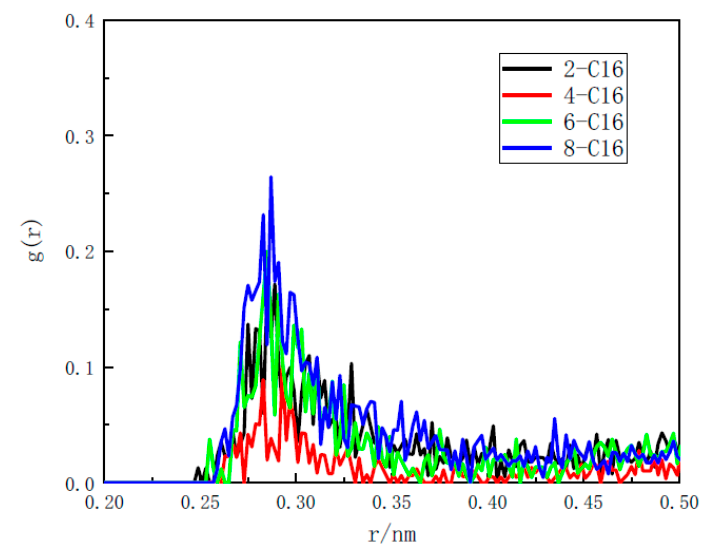
Figure 10. The RDF between O C and O W .